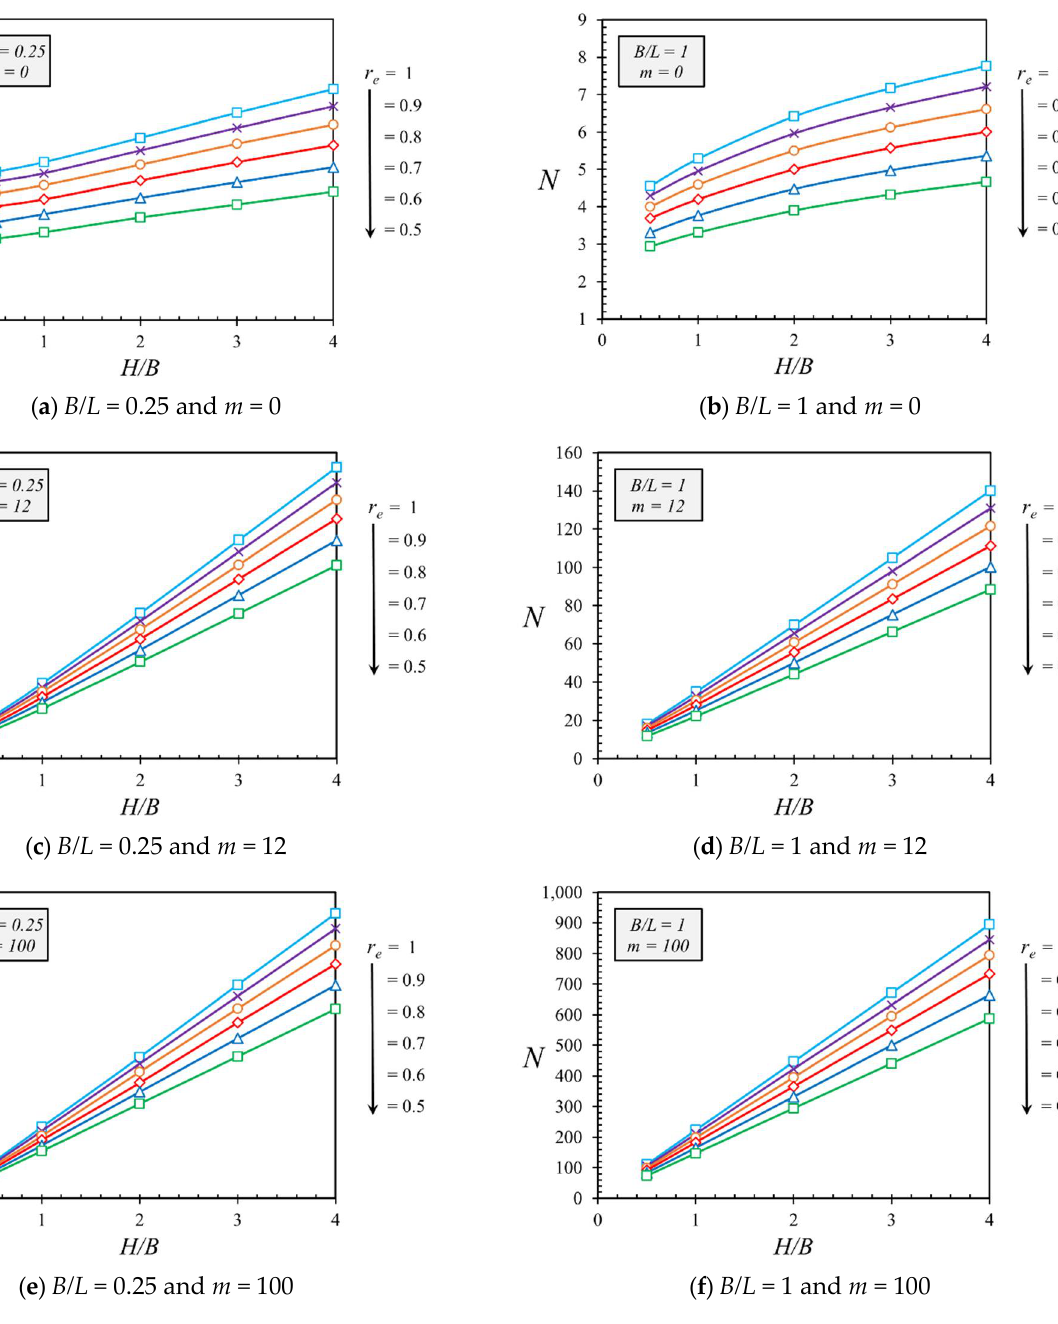
Figure 5. N vs. H/B for the various r e ( B/L = 0.25, 1.0 and m = 0, 12,